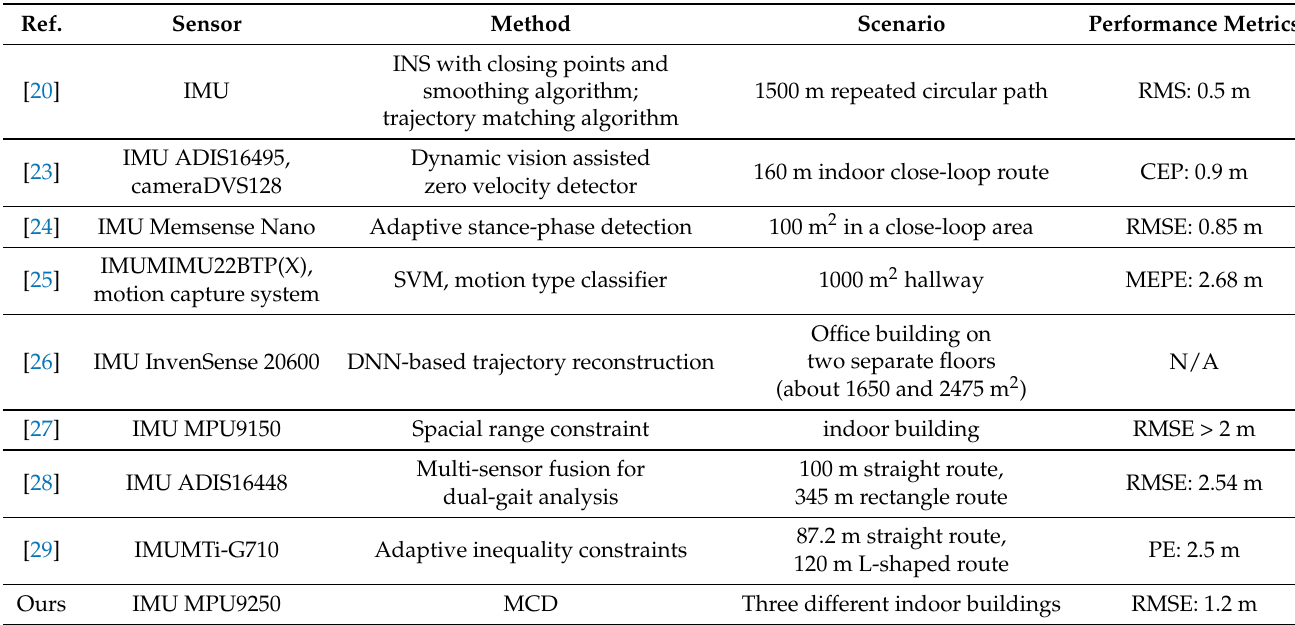
Table 8. Position error comparison with state-of-the-art studies.